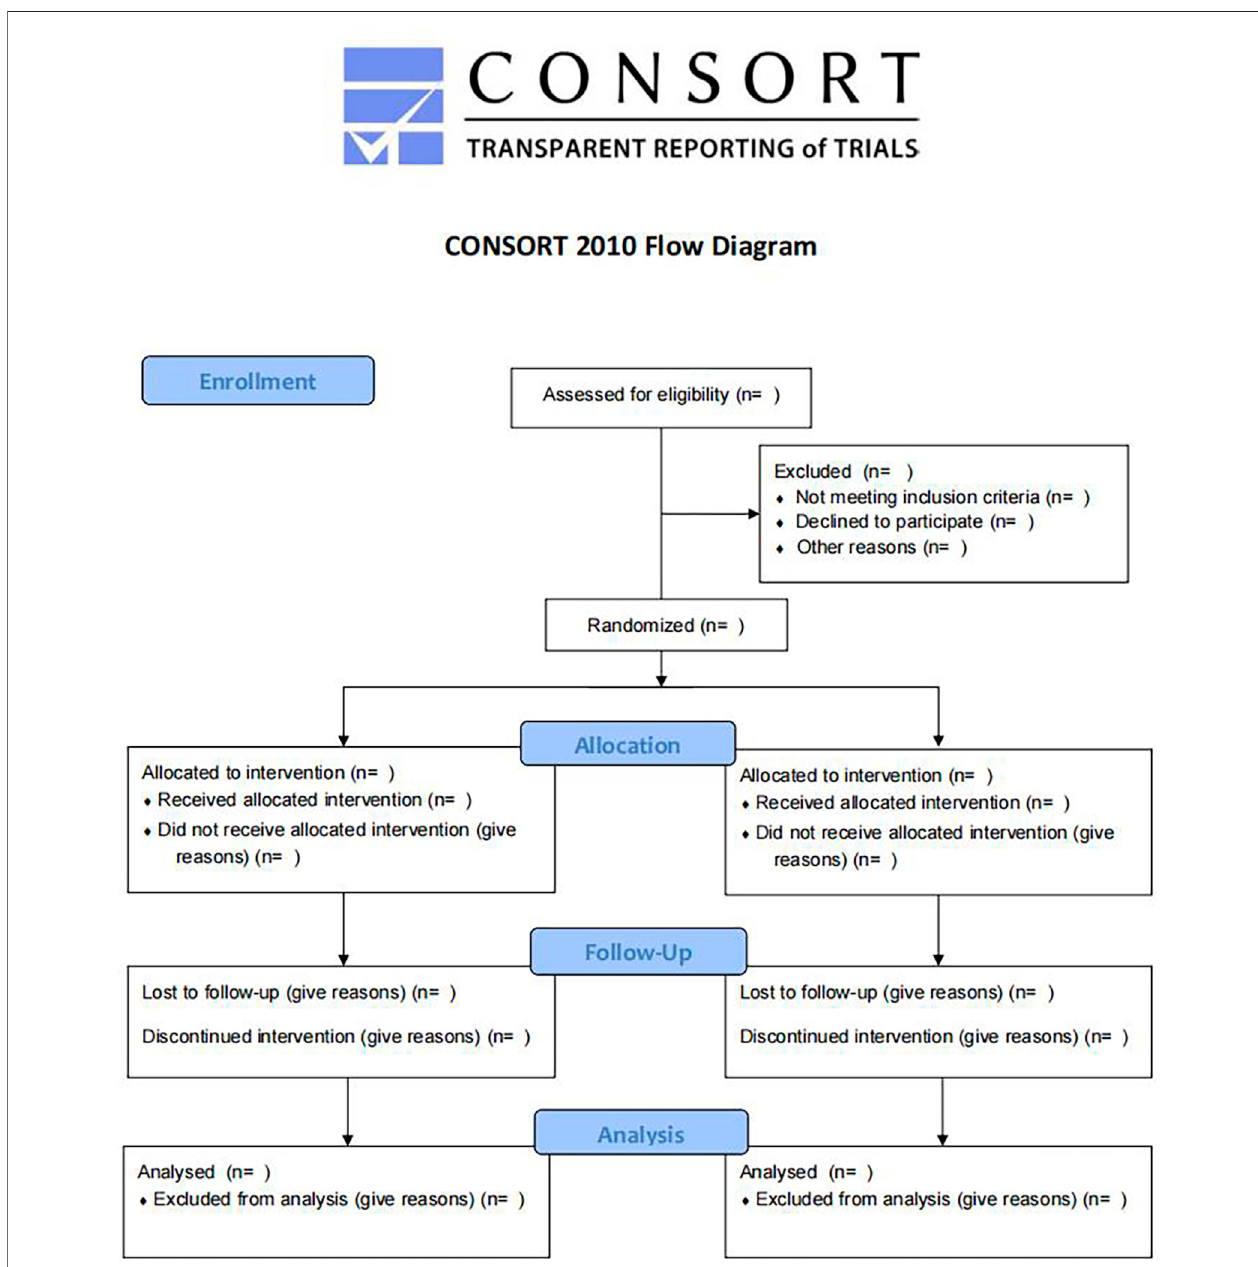
FIGURE 1 | Flow diagram of the